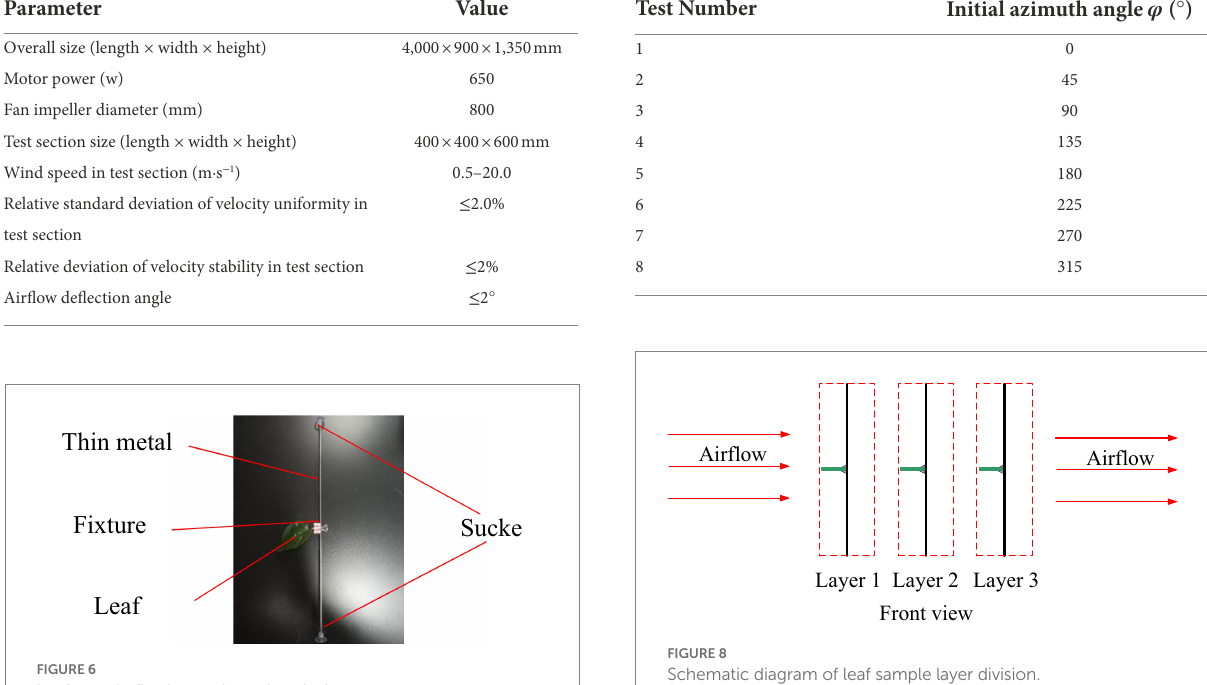
FIGURE 6 Leaf sample fixation and rotation device.